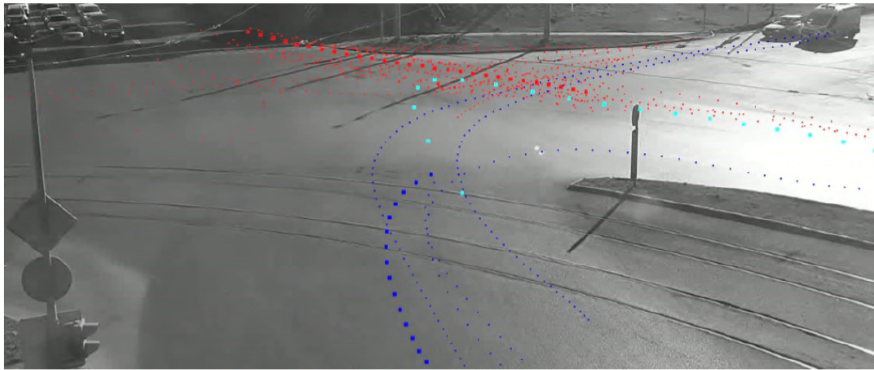
Figure 14. Results of the anomaly trajectory classification.